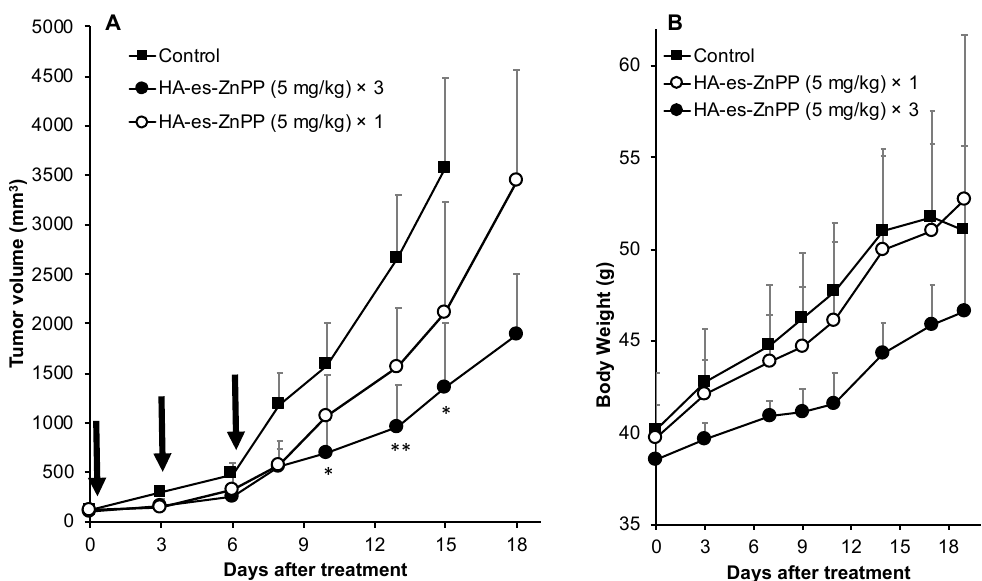
Figure 7. In vivo therapeutic effect of HA-es-ZnPP based PDT. In a mouse sarcoma S180 solid tumor model, HA-es-ZnPP (5 mg/kg, ZnPP equivalent) was injected i.v. when the tumor grew to 8–10 mm in diameter. At 24 and 48 h after injection of HA-es-ZnPP, irradiation to the tumors was carried out using xenon light (MAX-303; Asahi Spectra) at 400–700 nm for 5 min (36 J/cm 2 ). This treatment protocol was carried out 1 time or 3 times in different groups. The tumor volume ( A ) and body weight ( B ) of mice were recorded every 2–3 days during the study period. Arrows indicate the PDT treatments. Data are mean ± SD. *, p < 0.05; **, p < 0.01.